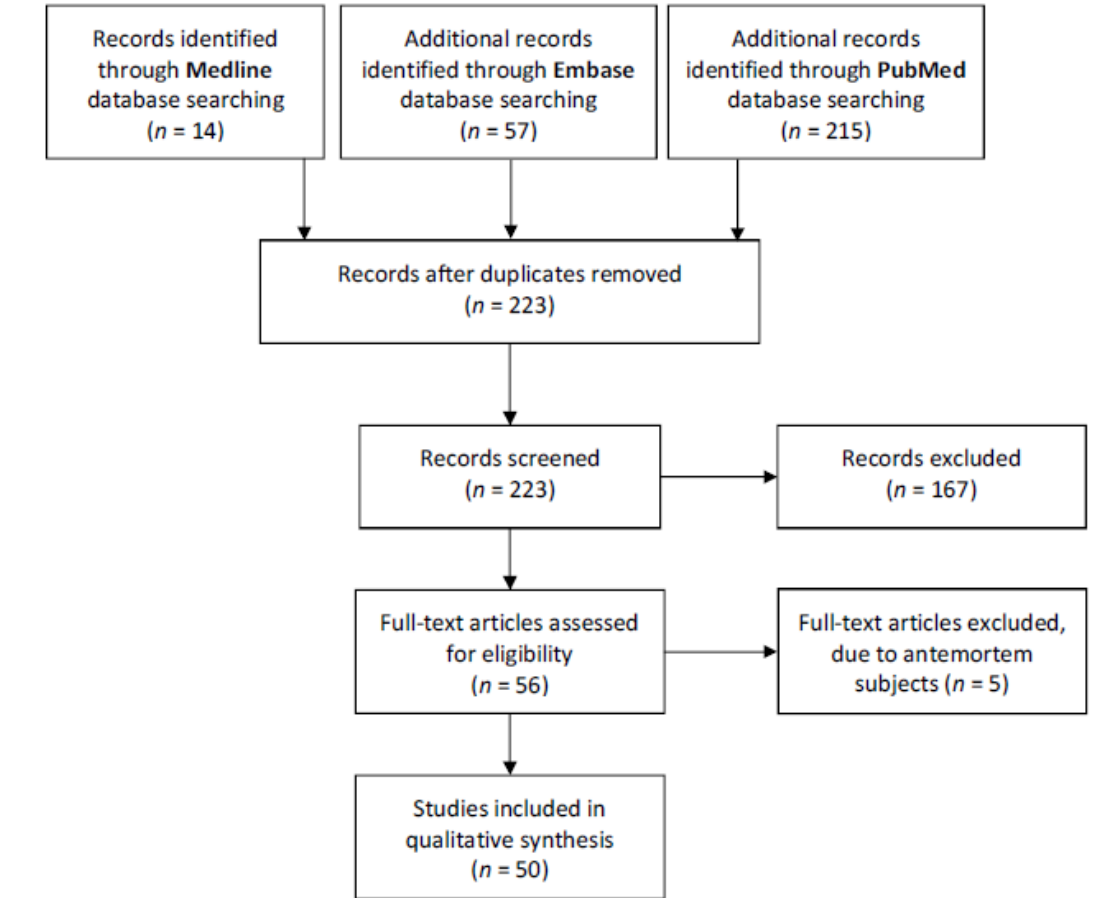
Figure 1. PRISMA flow diagram indicating strategies for literature search [16].